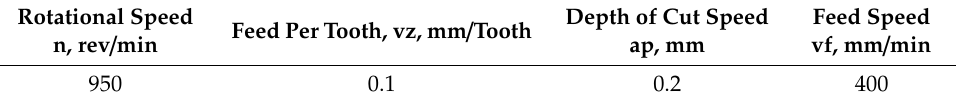
Table 1. Milling